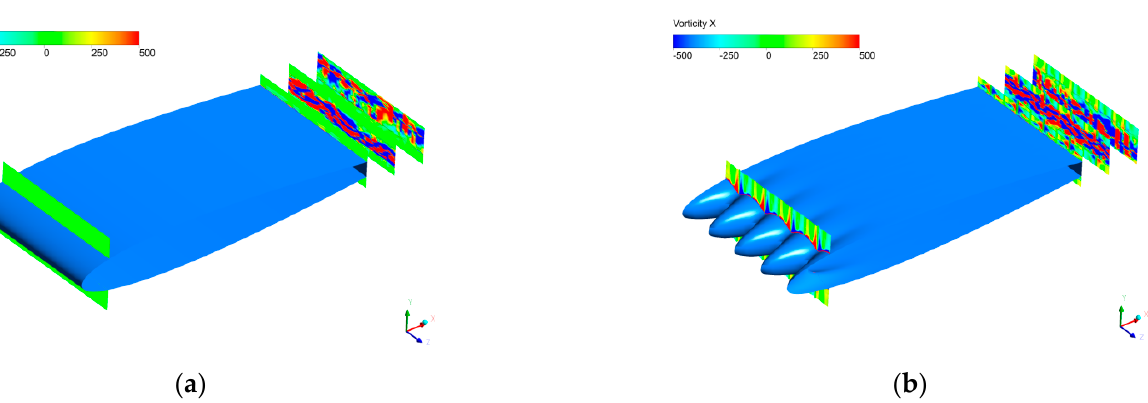
Figure 16. Streamwise vorticity distributions on several streamwise sections: ( a ) BaselineBlunt; ( b ) A10W10Blunt.